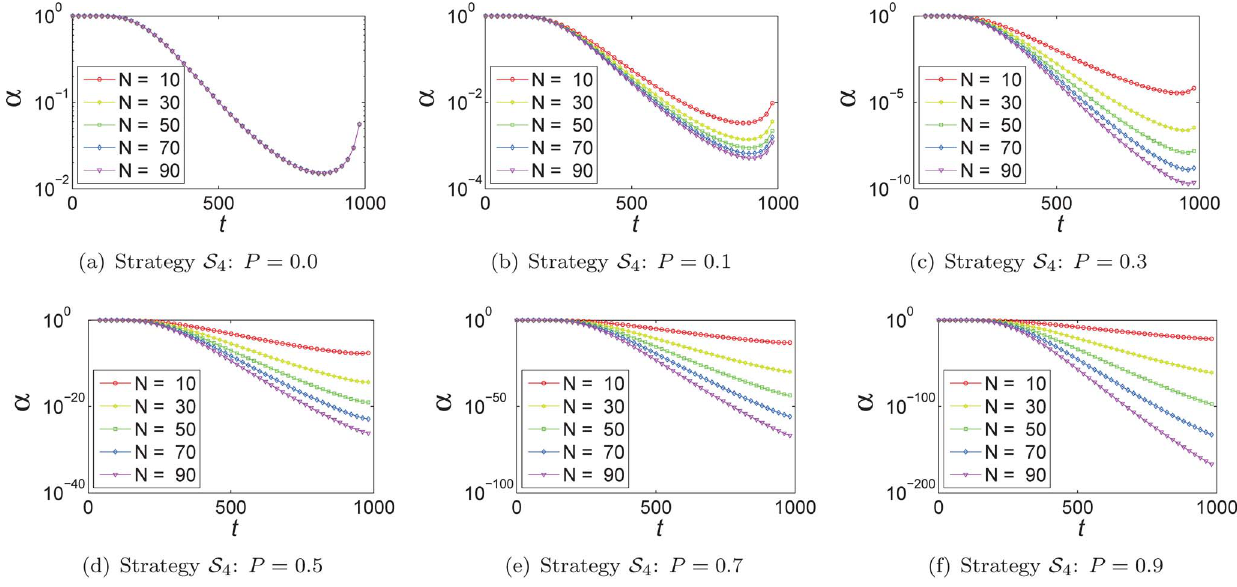
Figure 5. In strategy S 4 , the relationship between a and the population size N varying with different power value P .